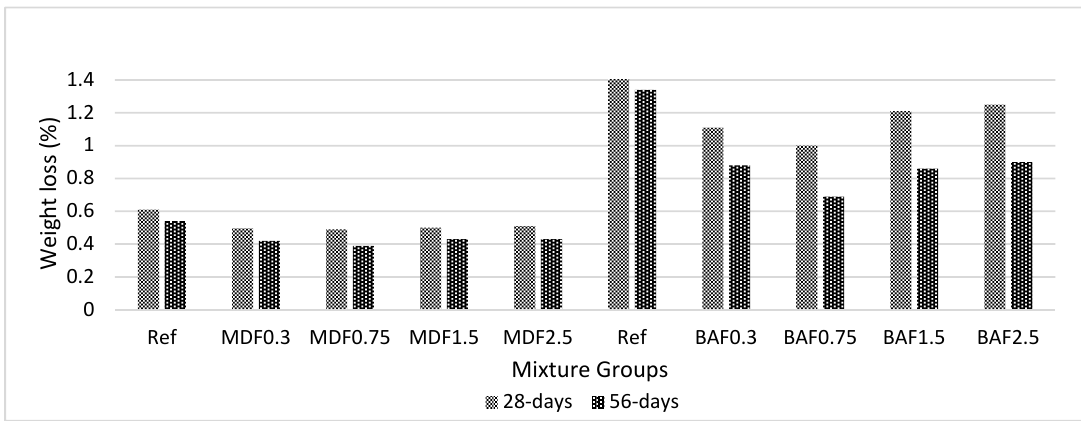
Figure 11. Effect of carbon fiber on sea water resistance for marble dust and bottom ash mixture groups at 28 and 56 days of curing.